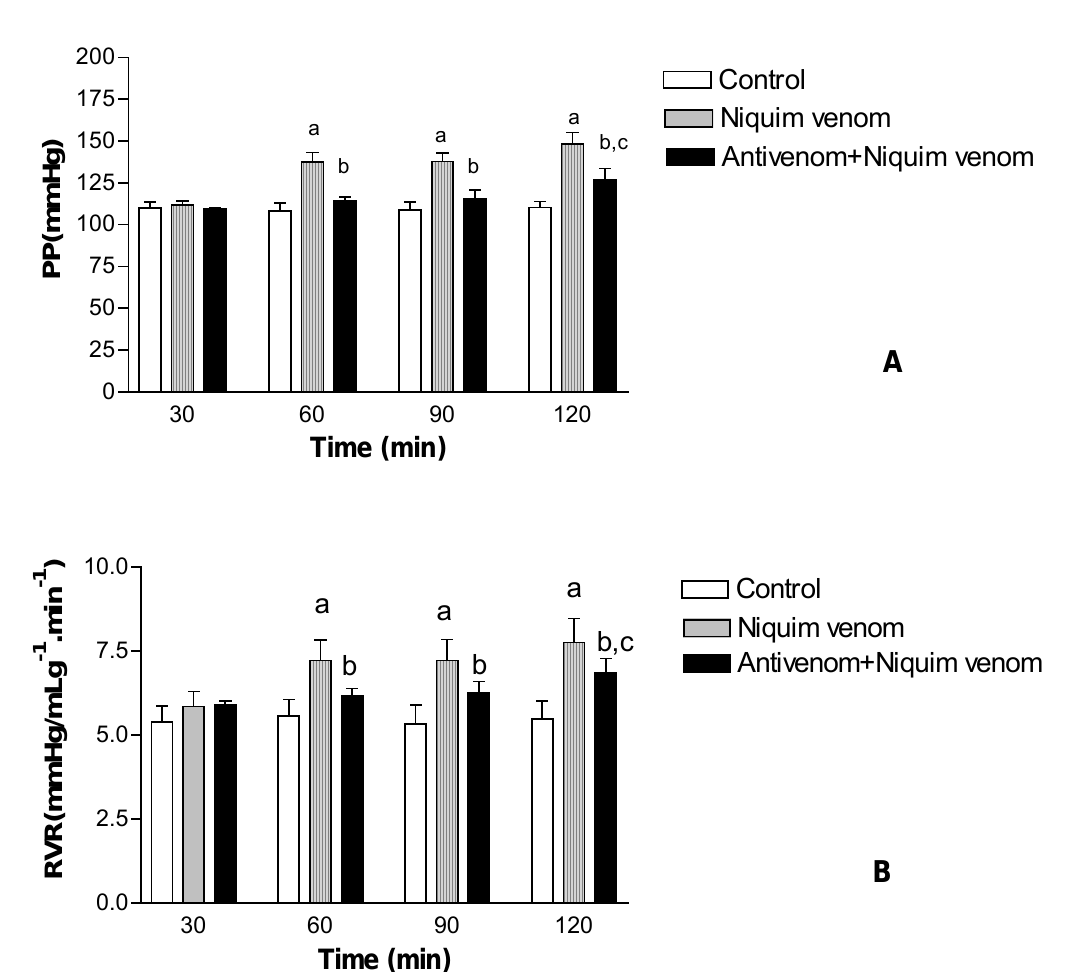
Figure 1. Action of the antivenom (1 µg/mL) on effects of Thalassophryne nattereri venom (1µg/mL) on perfusion pressure (PP; A ) and renal vascular resistance (RVR; B ). Data are expressed as means ± SEM from six different animals. ANOVA was employed for statistical analysis by comparison with the control group in which kidneys were perfused with only MKHS with a,b,c p <